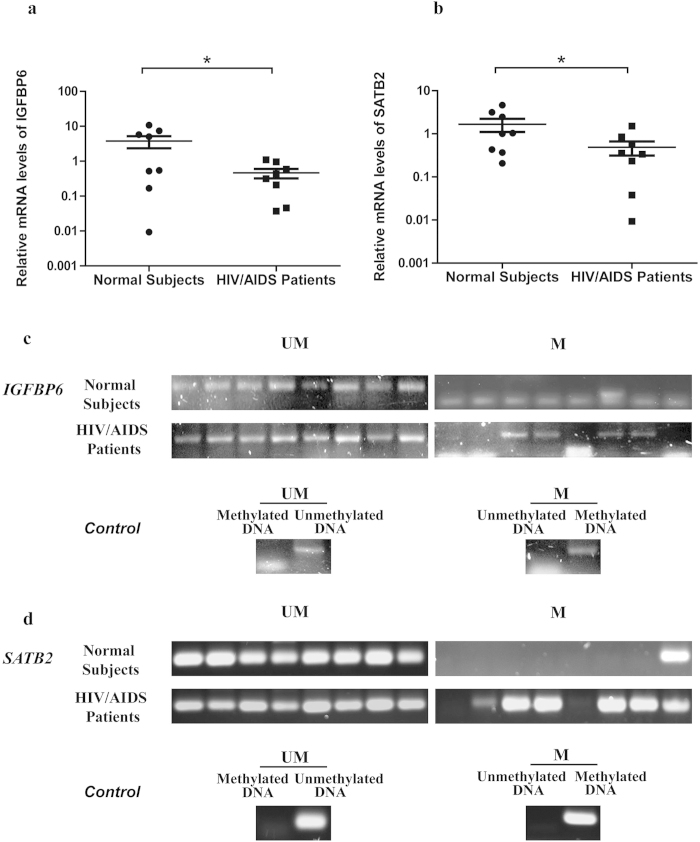
Comparison of relative expression level and methylation status of IGFBP6 and SATB2 between 8 HIV/AIDS patients and normal subjects.The mRNA expression levels of IGFBP6 (a) and SATB2 (b) were analyzed in 8 HIV/AIDS patients and 8 normal people. Round dots represent normal control; Rectangle dots represent HIV/ AIDS patients. The y-axis is plotted on a logarithmic scale. * P < 0.05, Mann-Whitney U test. Methylation status of IGFBP6 (c) and SATB2 (d) were checked by MSP. From left to right lanes in the HIV/AIDS patient panel, bands represent the methylated PCR products from patients 1 to 8. M, PCR for CpG-methylated DNA; UM, PCR for CpG-unmethylated DNA. Fully uncut gel images are shown in Supplementary Figures.